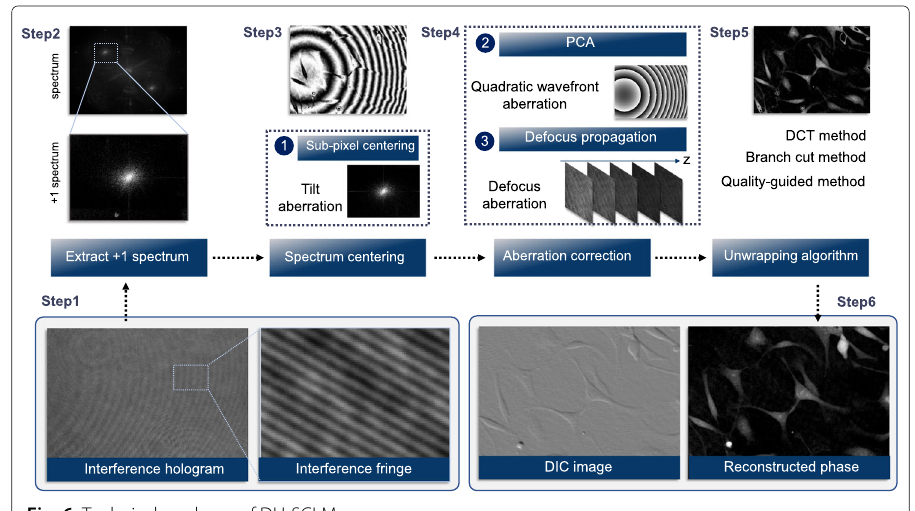
Fig. 6 Technical roadmap of